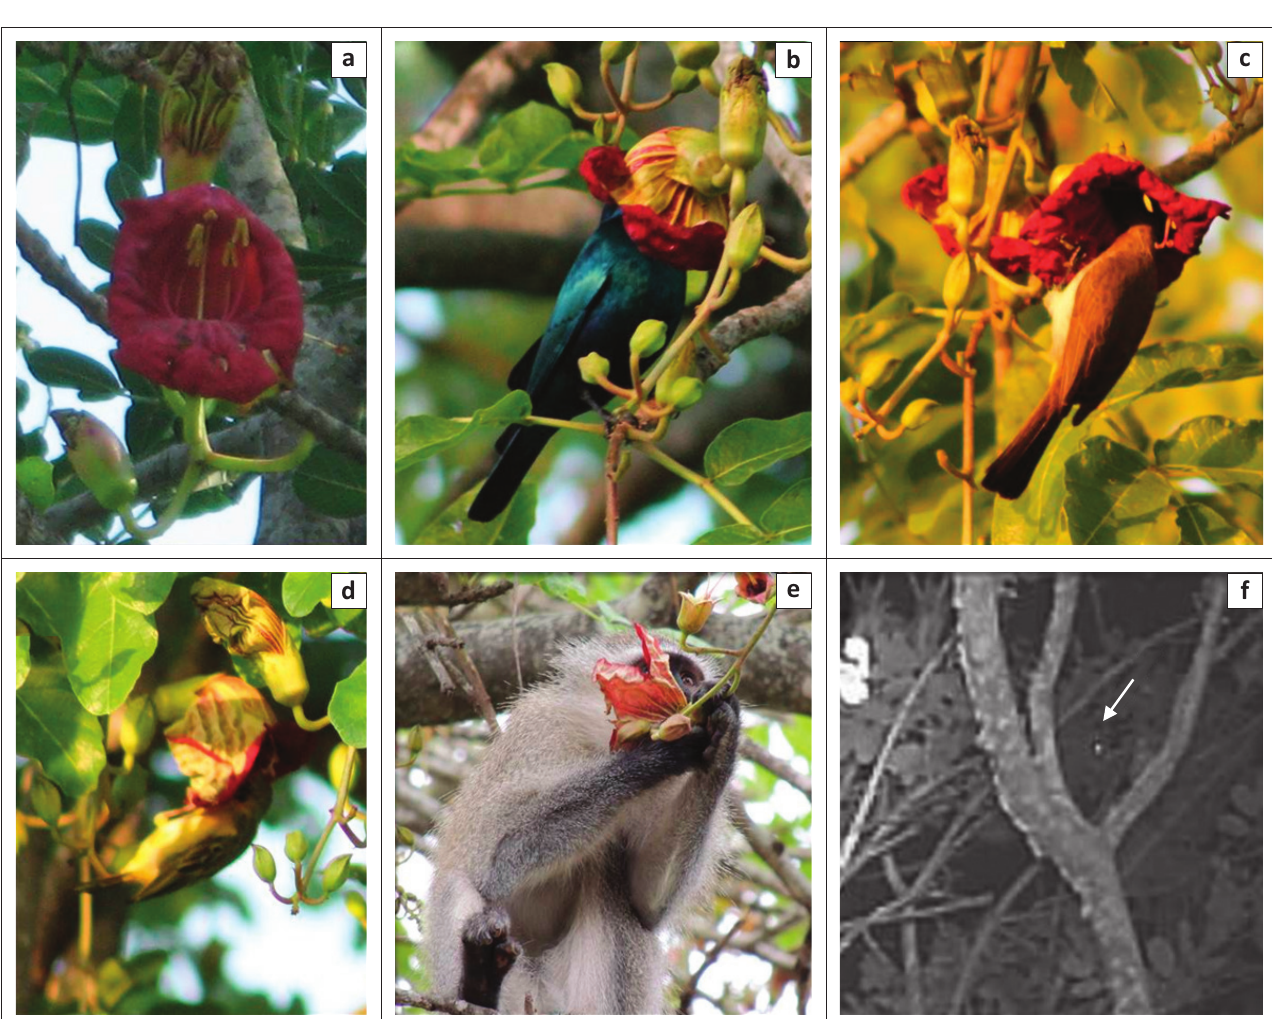
FIGURE 3: Kigelia africana and its various pollination vectors: (a) open flower and two buds on a stalk, (b) glossy starling ( Lamprotornis nitens ), (c) dark-capped bulbul ( Pycnonotus tricolor ) perching on the stalk and reaching for the nectar, (d) southern masked weaver ( Ploceus velatus ), clumsily perching on the flower petal to get to the nectar, (e) vervet monkey ( Chlorocebus pygerythrus ) lapping at the nectar, and (f) still of a video shot, illustrating a genet ( Genetta tigrina ) sniffing one of the flowers before placing its snout into the flower.